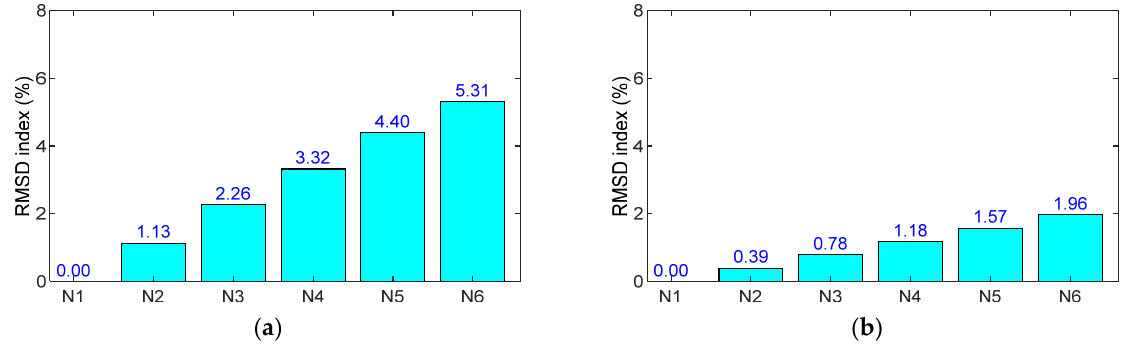
Figure 11. RMSD indices of numerical impedance signals of PZT sensors in the concrete sample under compression: ( a )